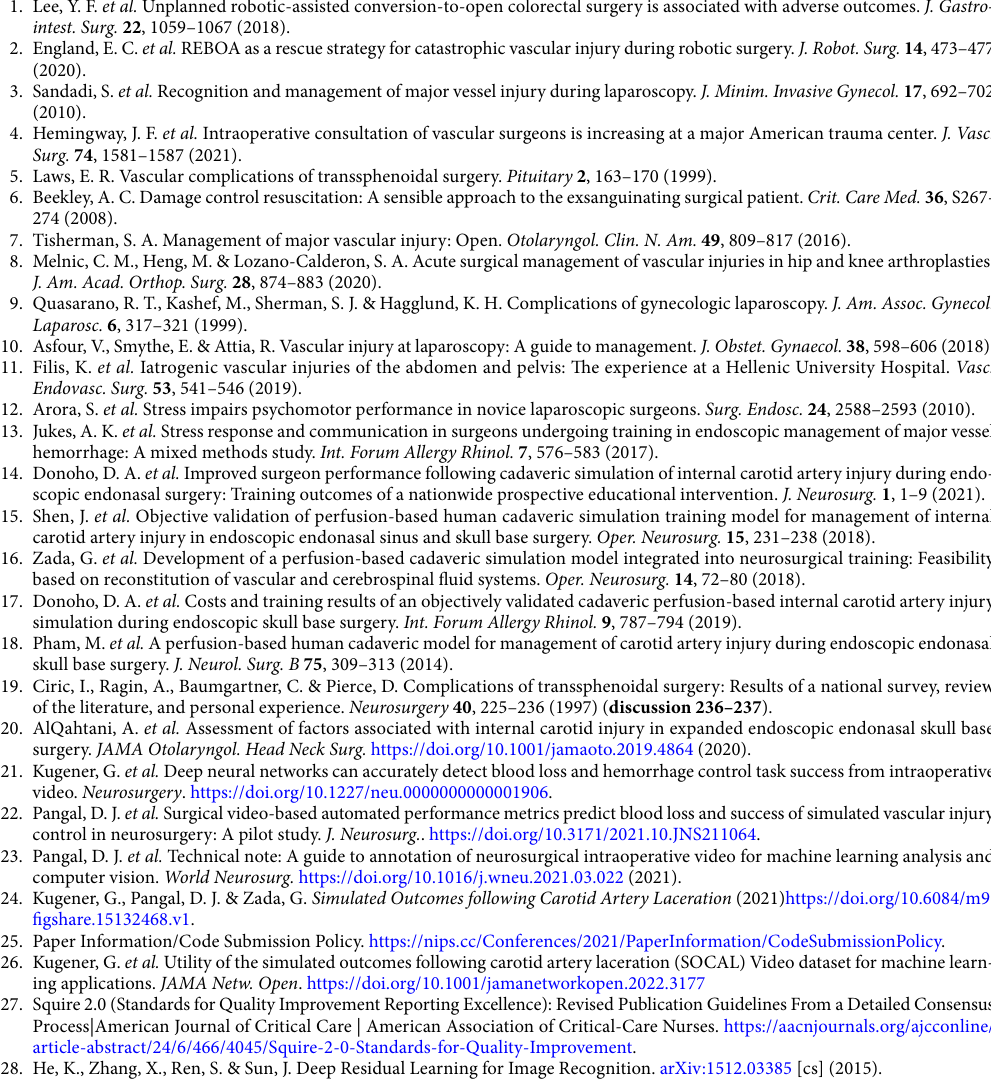
figsh are. 15132 468. v1. 25. Paper Information/Code Submission Policy. https:// nips. cc/ Confe rences/ 2021/ Paper Infor mation/ CodeS ubmis sionP